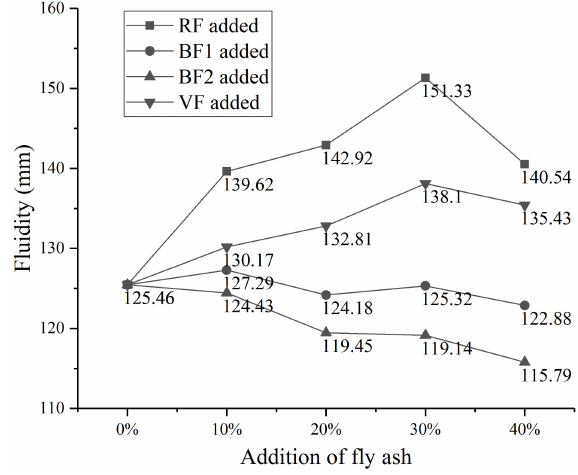
Figure 5. Fluidity of cement paste containing different fly